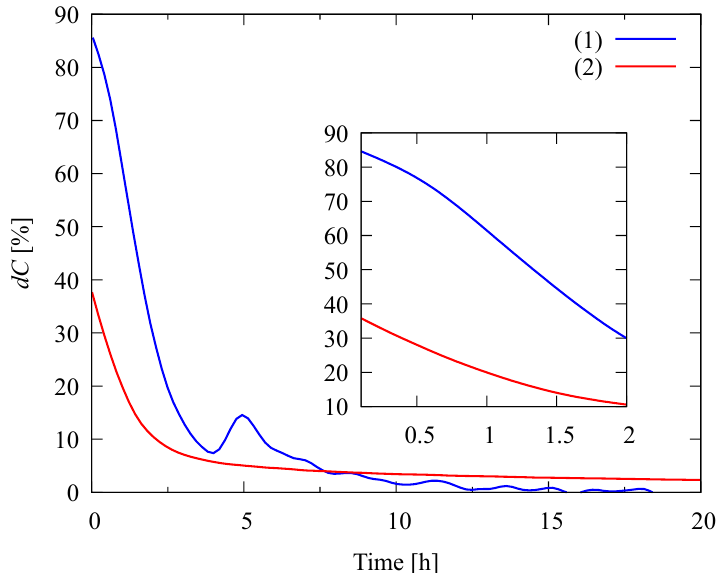
Figure 13. The dimensionless rate of salt absorption by the porous layer (1) and the dimensionless rate of salt desorption from the saturated state after stopping the brine discharge